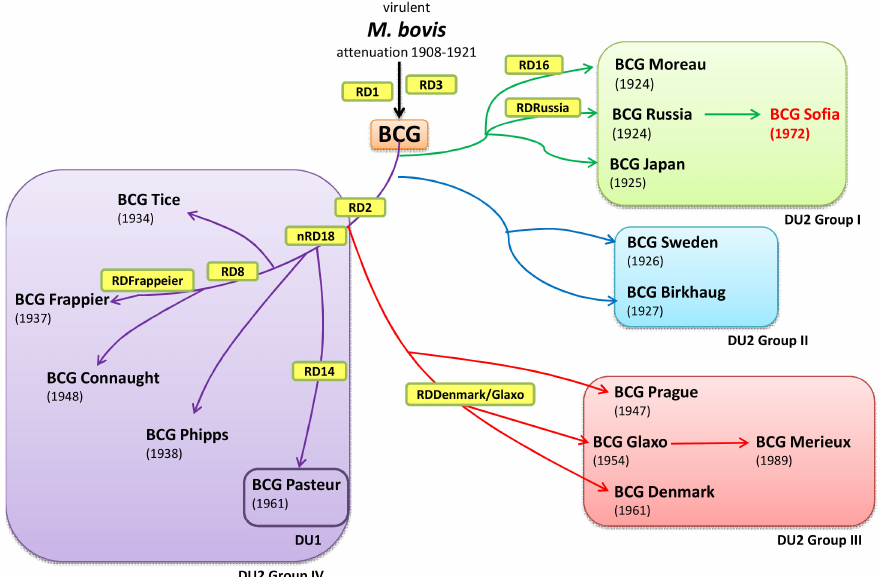
Figure 1. Evolution of the BCG sub-strains according to historical and genetic data. Phylogenetic positioning of BCG SL222 Sofia among the BCG